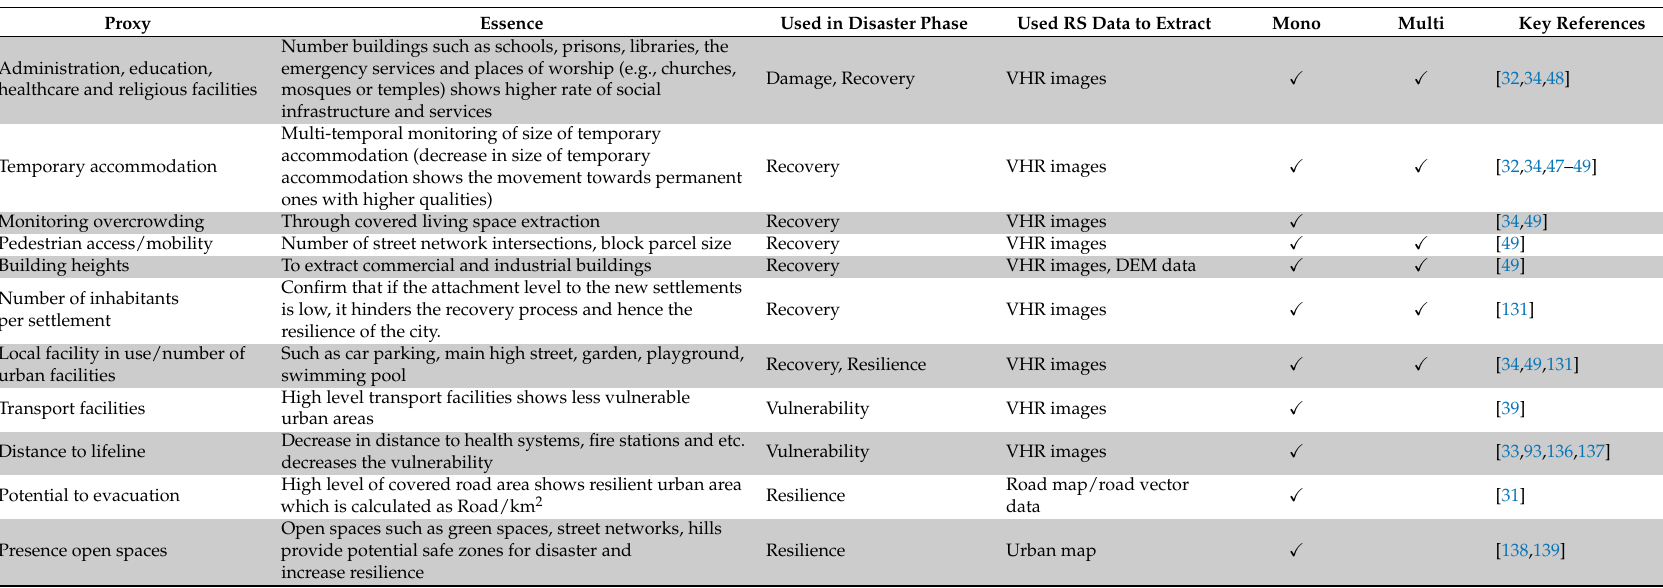
Table 6. Remote sensing-based social proxies for urban DRM, Services and infrastructures category. Mono and Multi refer to mono-temporal and multi-temporal RS data that used for extraction,